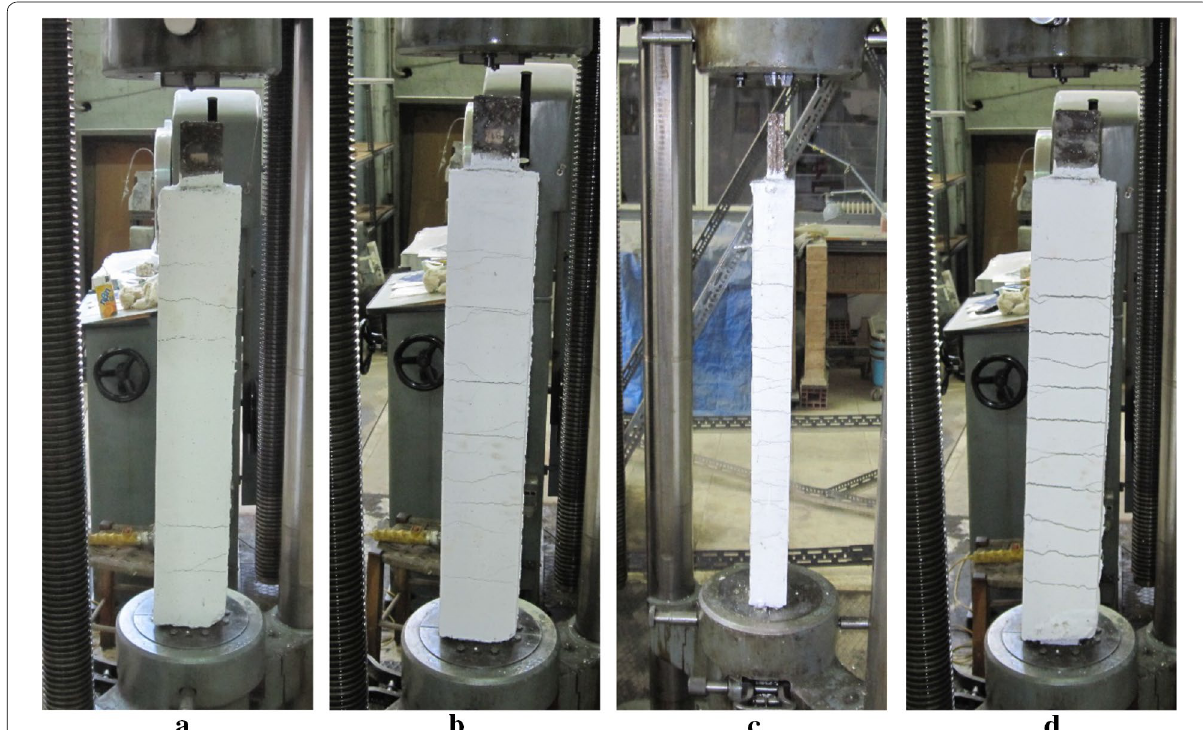
Fig. 4 State of specimens after the end of the tensile experiment: a C-10, b C-20, c C-30, d C-50.